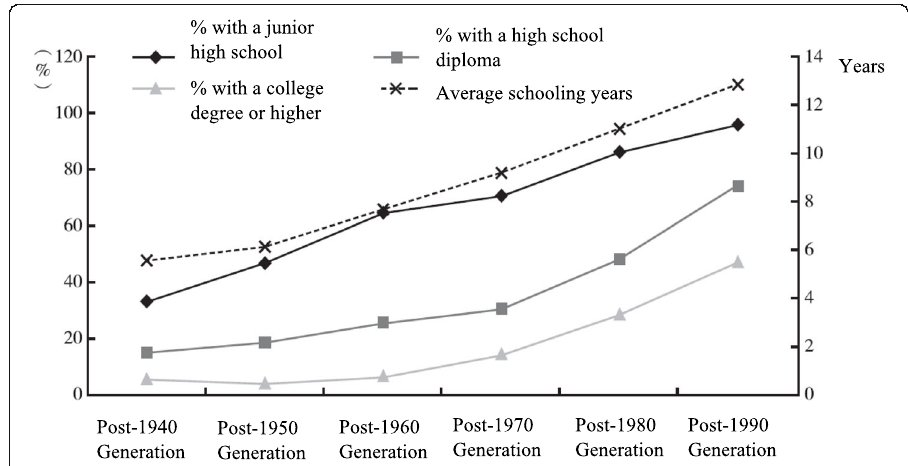
Fig. 2 Generational disparities in opportunities of receiving secondary education and higher education and in average schooling